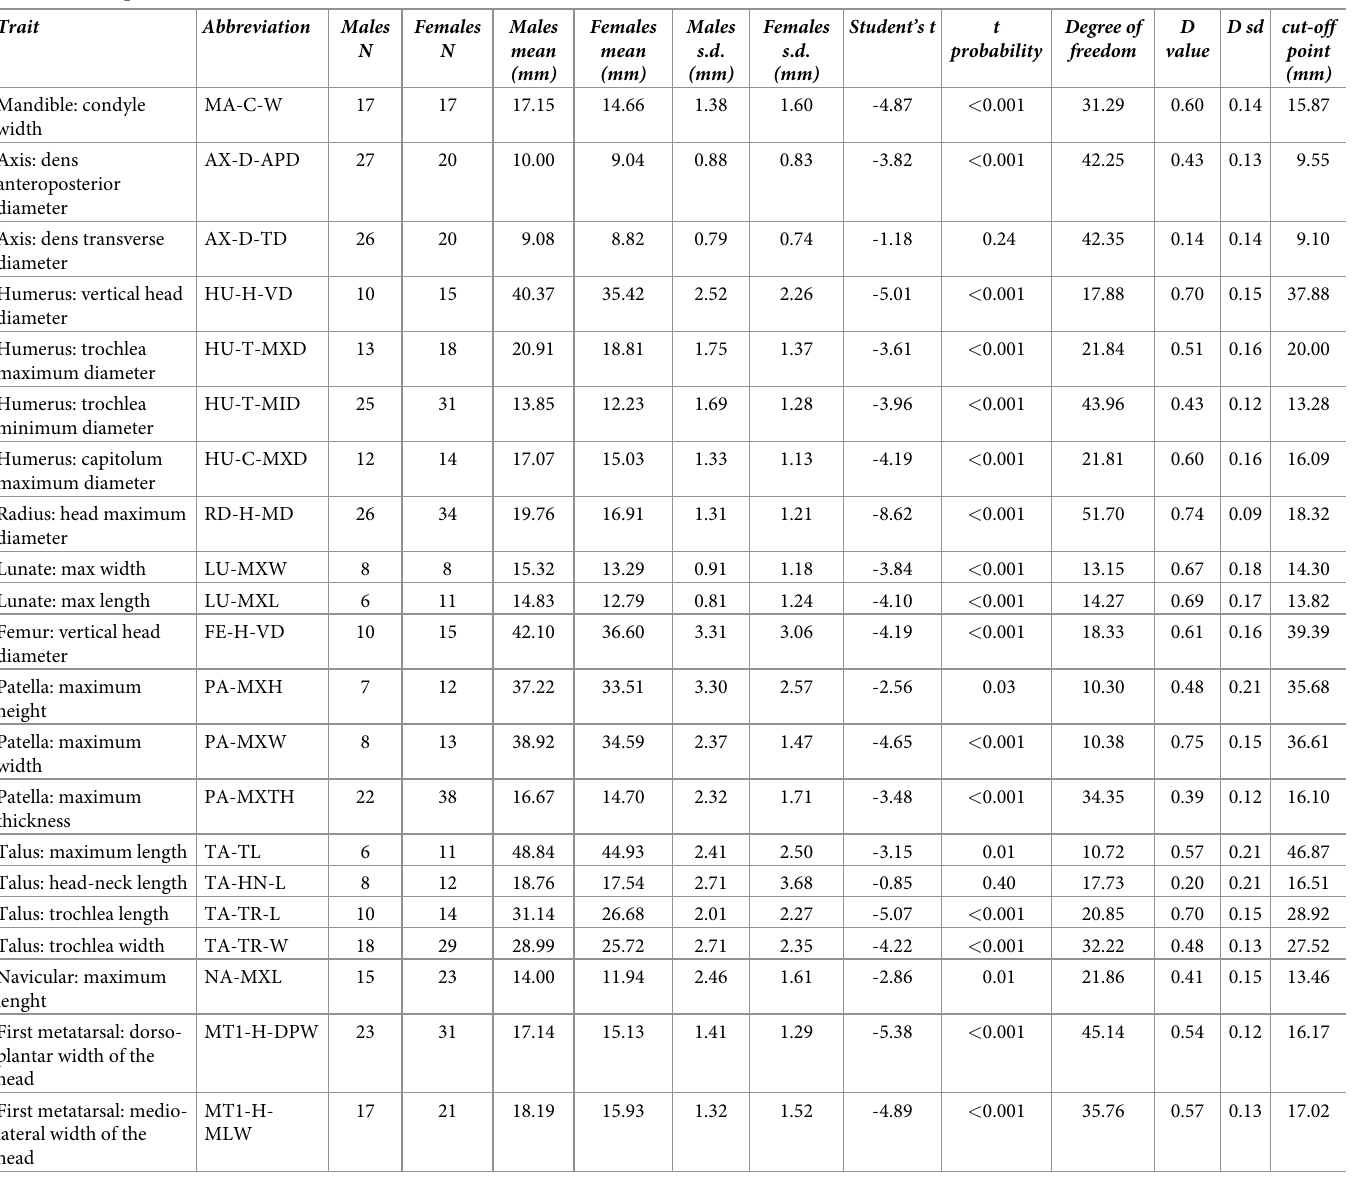
Table 3. Descriptive and inferential statistics of 21